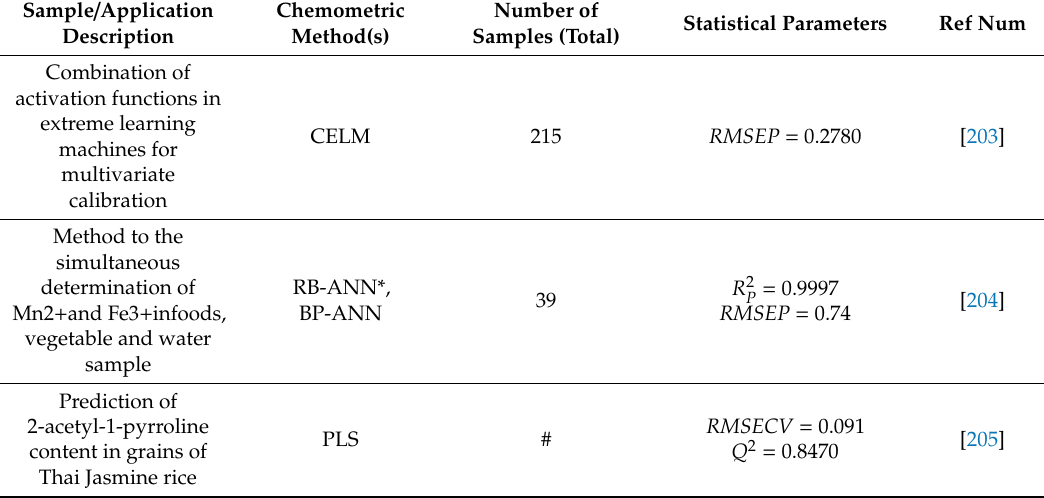
Table 10. Literature related to the use of chemometrics in prediction of properties of